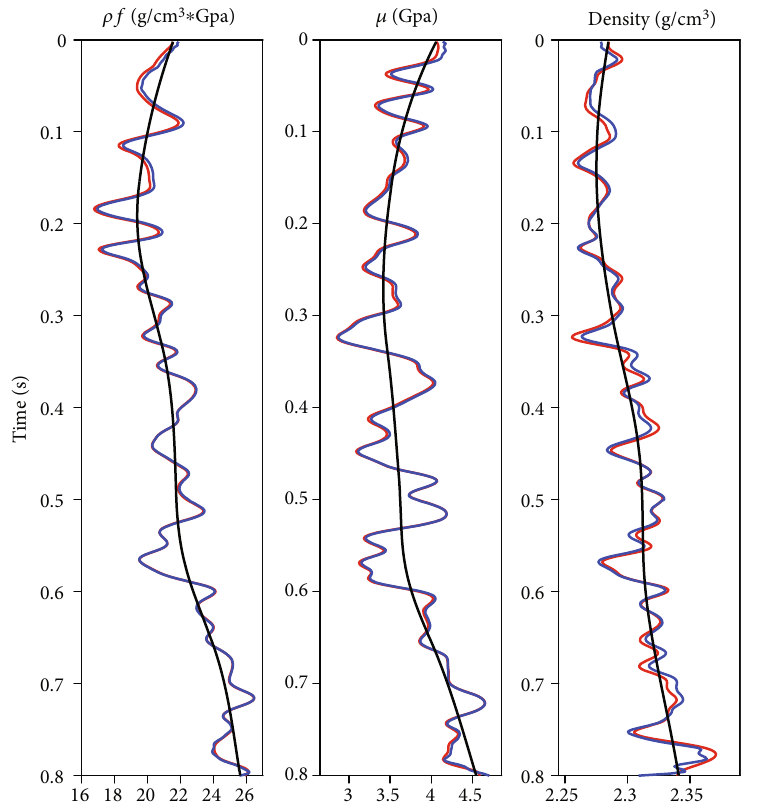
Figure 6: Inversion results of the traditional method based on Russell linear approximation.